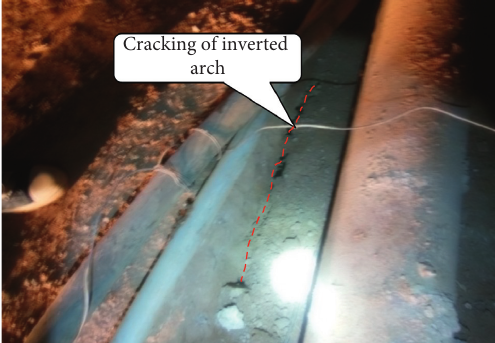
Figure 10: Cracking and settlement of the preliminary lining structure.